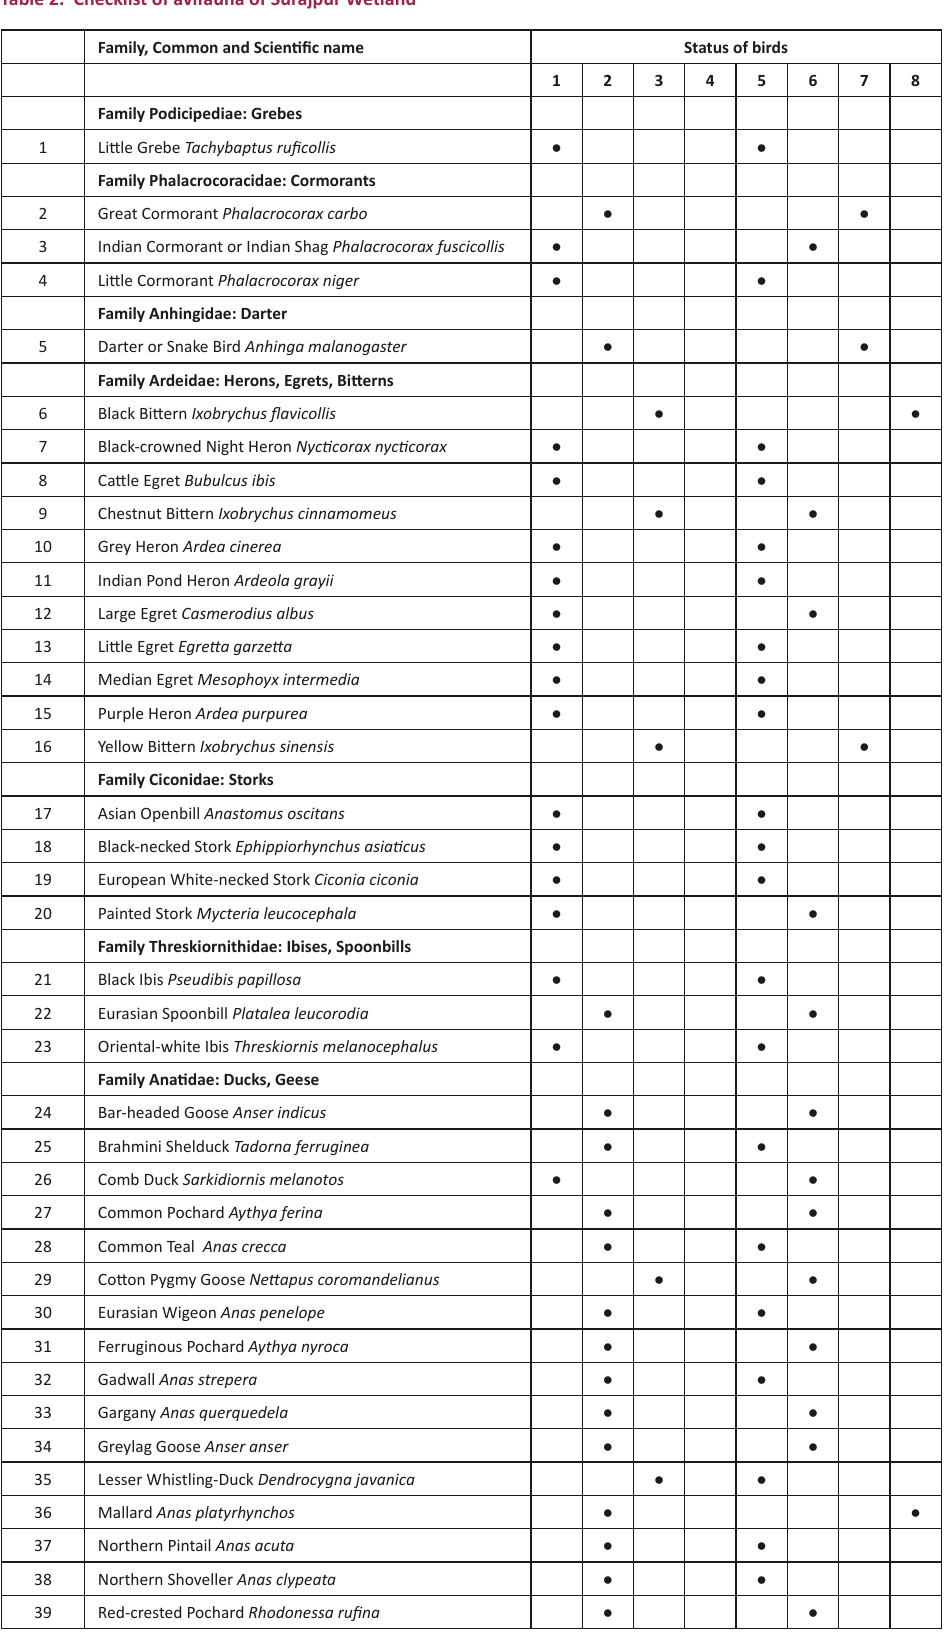
Table 2. Checklist of avifauna of Surajpur